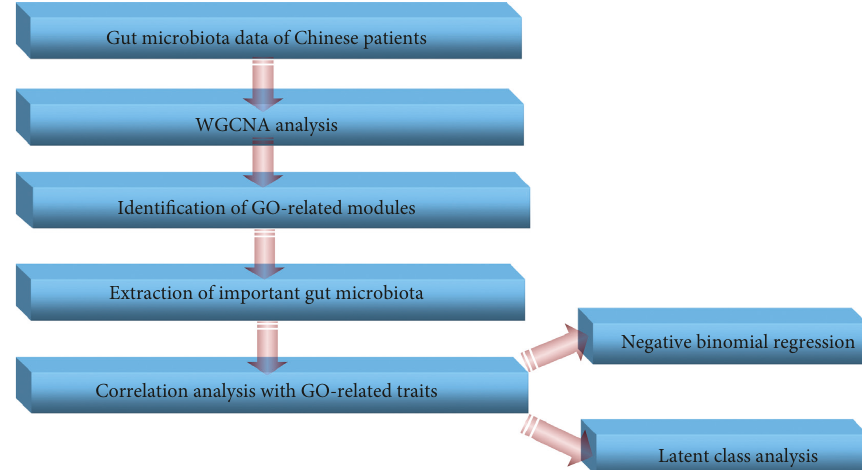
Figure 1: Flowchart of our work. Firstly, WGCNA was used to generate the network and to identify GO-related network modules based on the OTU relative abundance. Those gut microbiota with outstanding topological properties were extracted. Secondly, the module-trait association analysis was performed, and the Pearson correlation analysis was used to determine the association between each of the OTUs involved in the modules and GO-related traits. Thirdly, the relationships between the identified bacteria and GO-related traits were further investigated based on the negative binomial regression after adjusting for age and sex. Finally, the identified bacteria were used to classify GO patients by applying the latent class analysis.